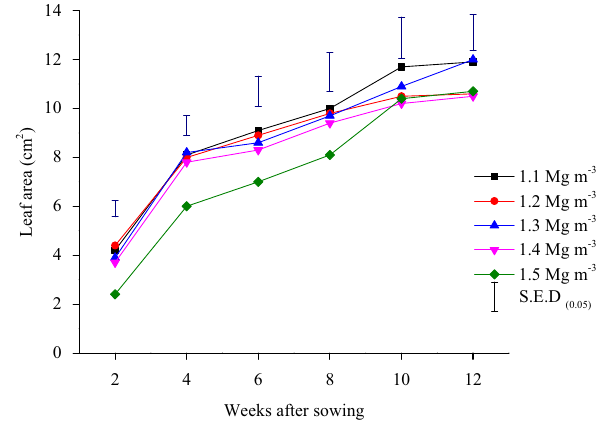
Figure 5: Leaf area of groundnut plant as in fl uenced by soil com - paction in year